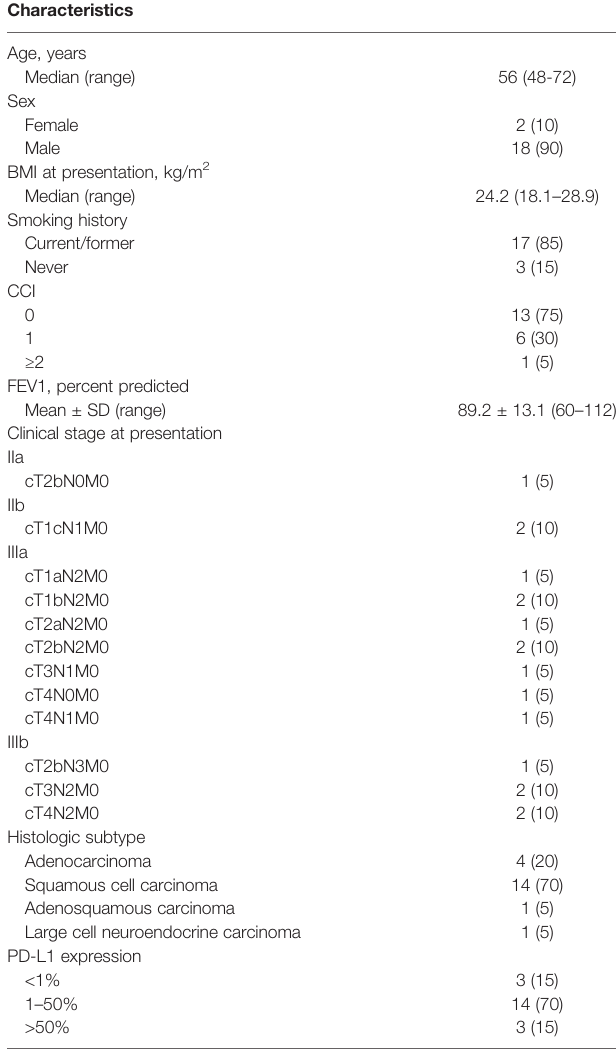
TABLE 1 | Patient and cancer